Question: What form of chart is displayed?
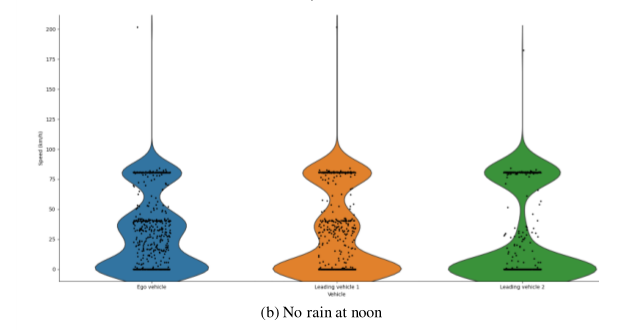
Answer: line